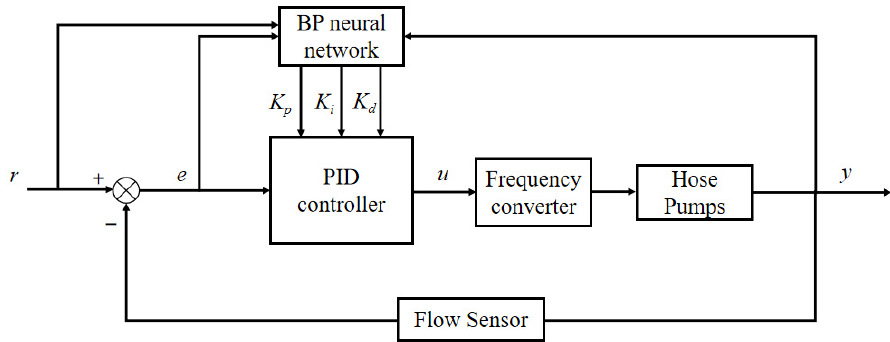
Figure 3. Structure of the BP neural network-based PID controller.